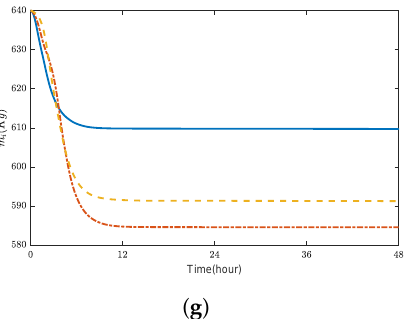
Figure 8. Estimation of the inertia matrix and mass under the proposed adaptive